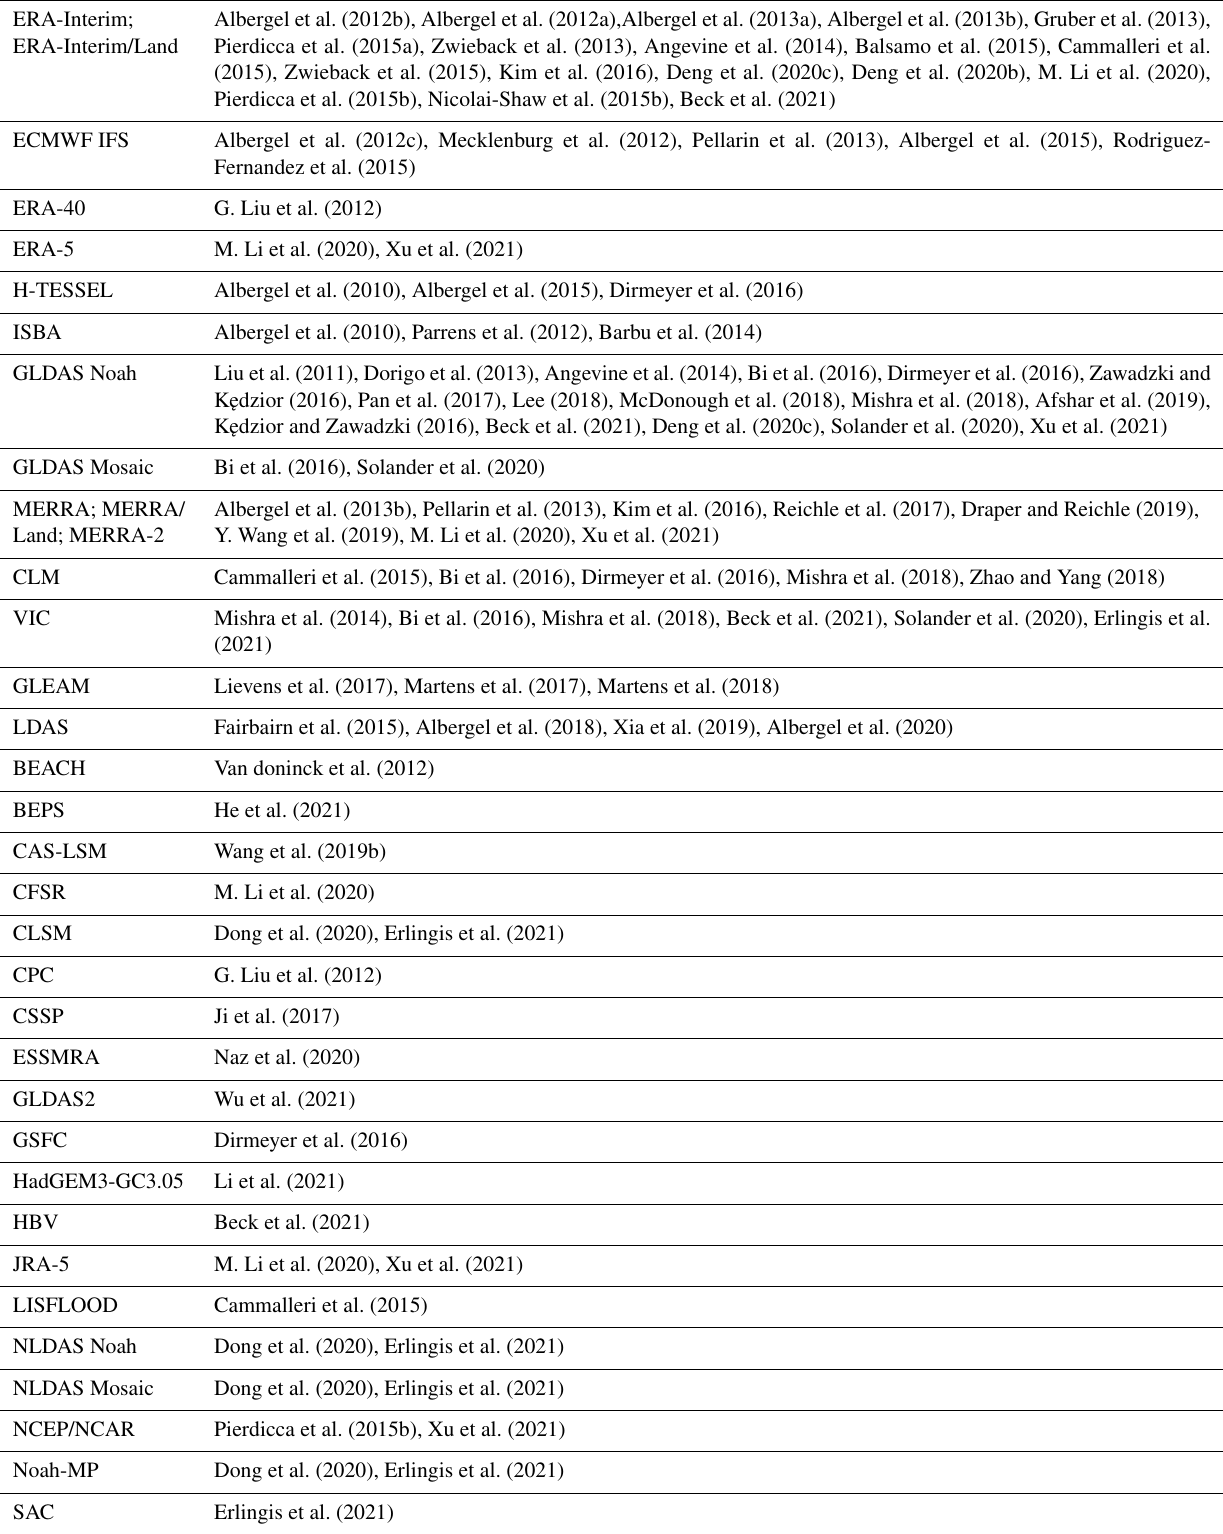
Table E2. Overview of scientific studies using ISMN data for model evaluation and development.